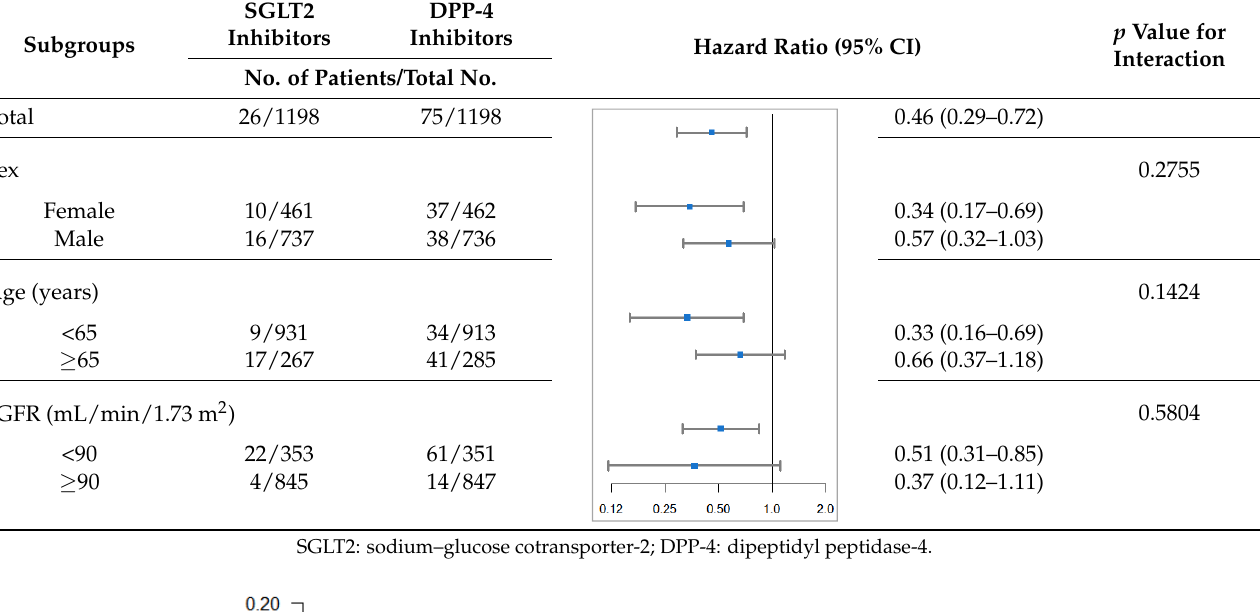
Table 2. Subgroup analyses of renal events for SGLT2 inhibitors group compared with DPP-4 inhibitors group.